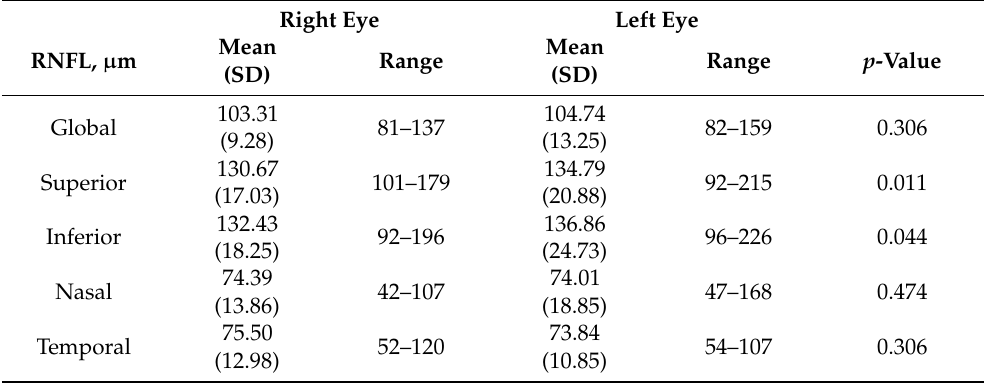
Table 3. Global and sectorial RNFL thickness means filtered by eye laterality on the Spectralis